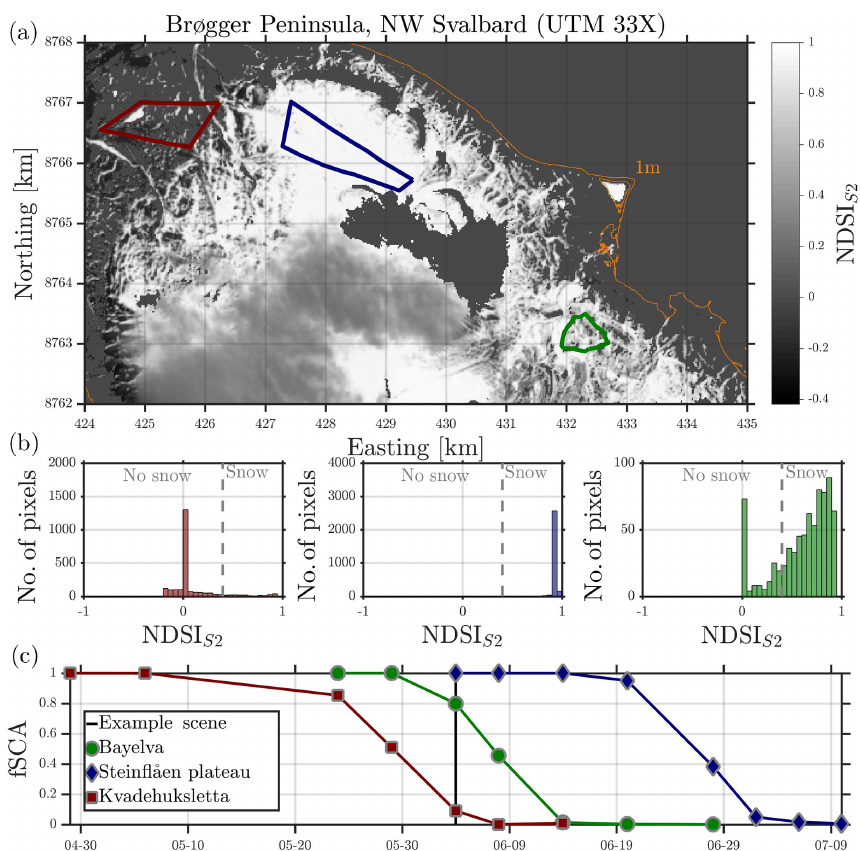
Figure 2. (a) Sentinel-2 NDSI estimates from an example scene (4 June 2016) over the Brøgger Peninsula with Kvadehuksletta, Steinflåen plateau and Bayelva marked with red, green and blue polygons, respectively; coastline in orange. (b) NDSI histograms of the same example scene (Kvadehuksletta: left; Steinflåen plateau: middle; Bayelva: right) with the threshold at NDSI = 0 . 4 marked. (c) Time series of Sentinel-2 NDSI-based fSCA retrievals for the 2016 melt